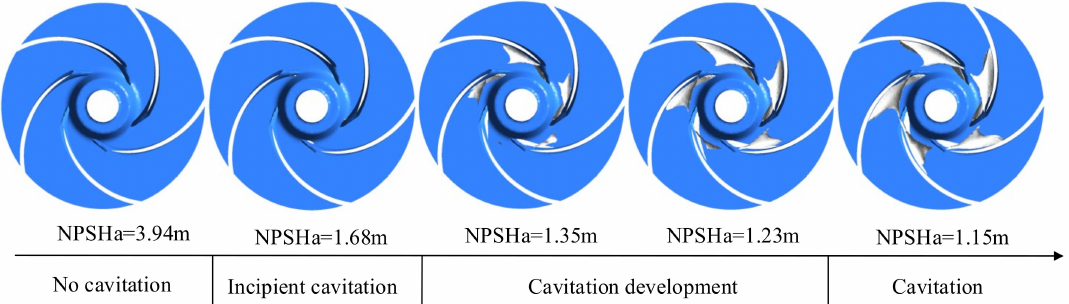
Figure 10. Bubble distribution during the cavitation formation